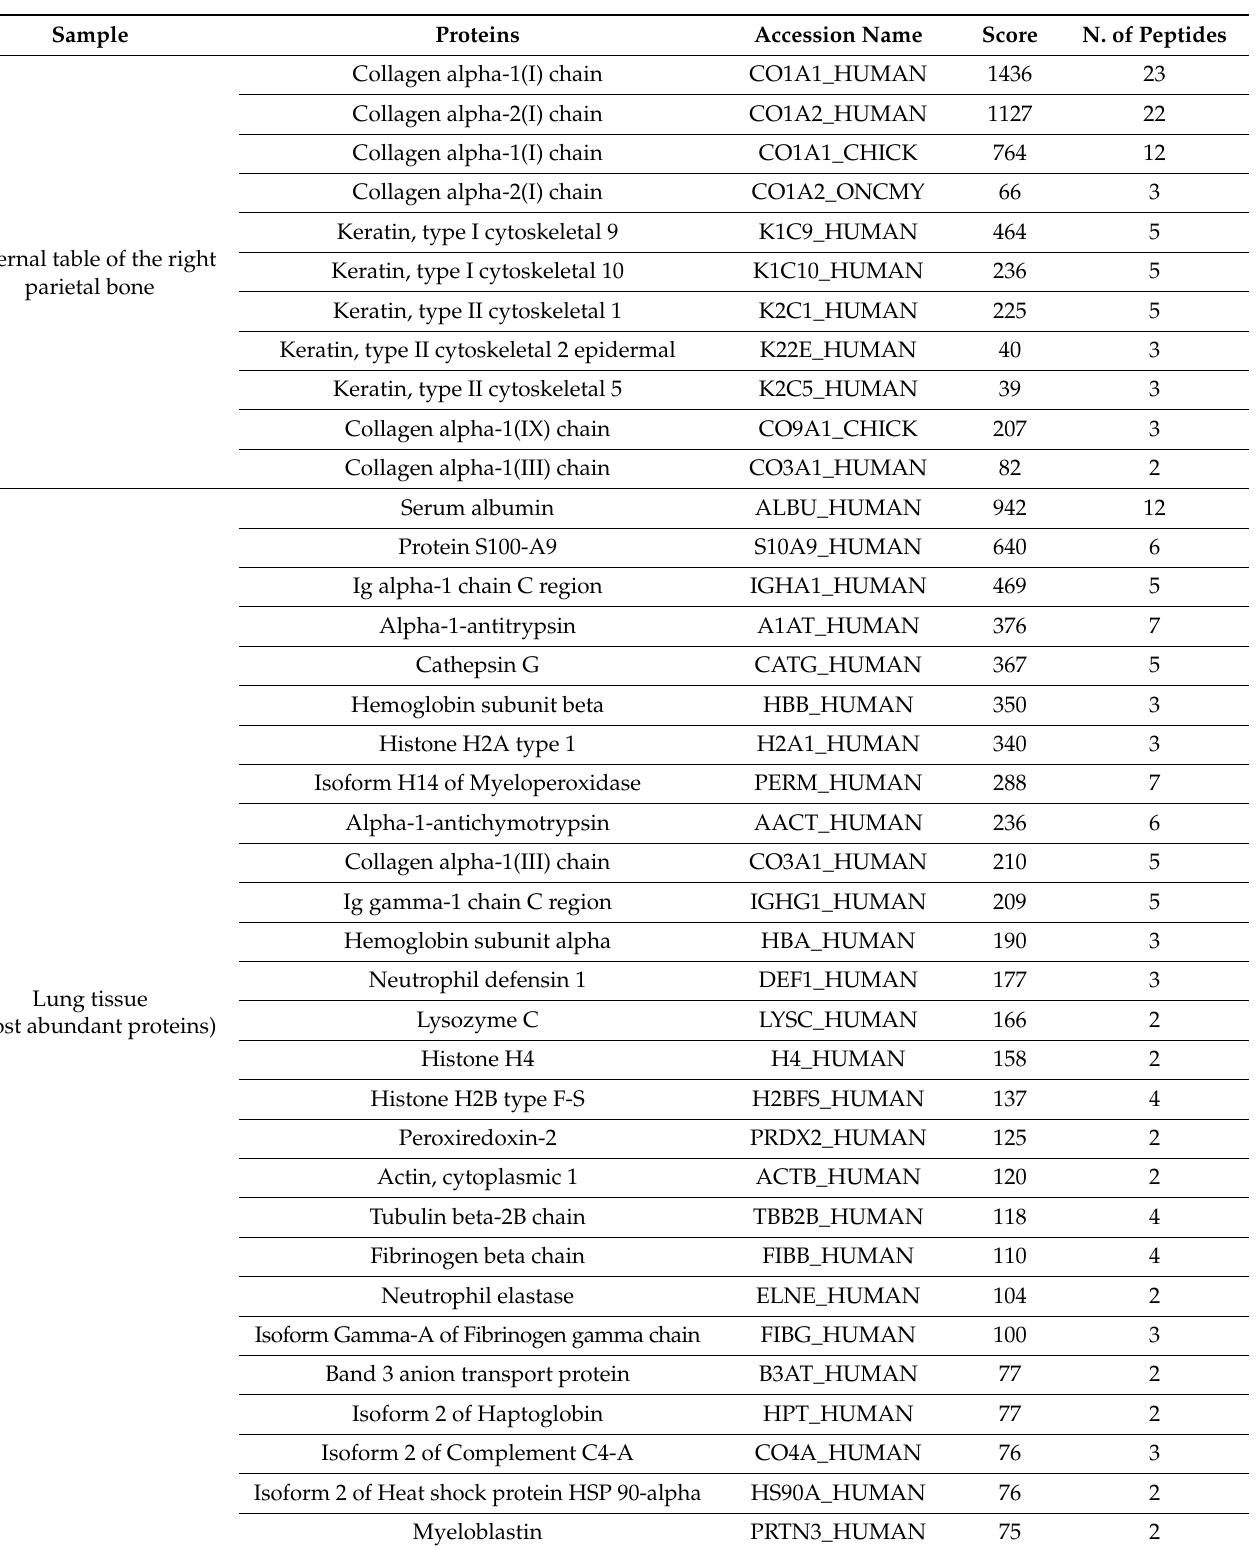
Table 1. Proteins identified in the head and in the lung of Nebiri. Sample, proteins, accession name, score, and number of peptides identified for each protein are